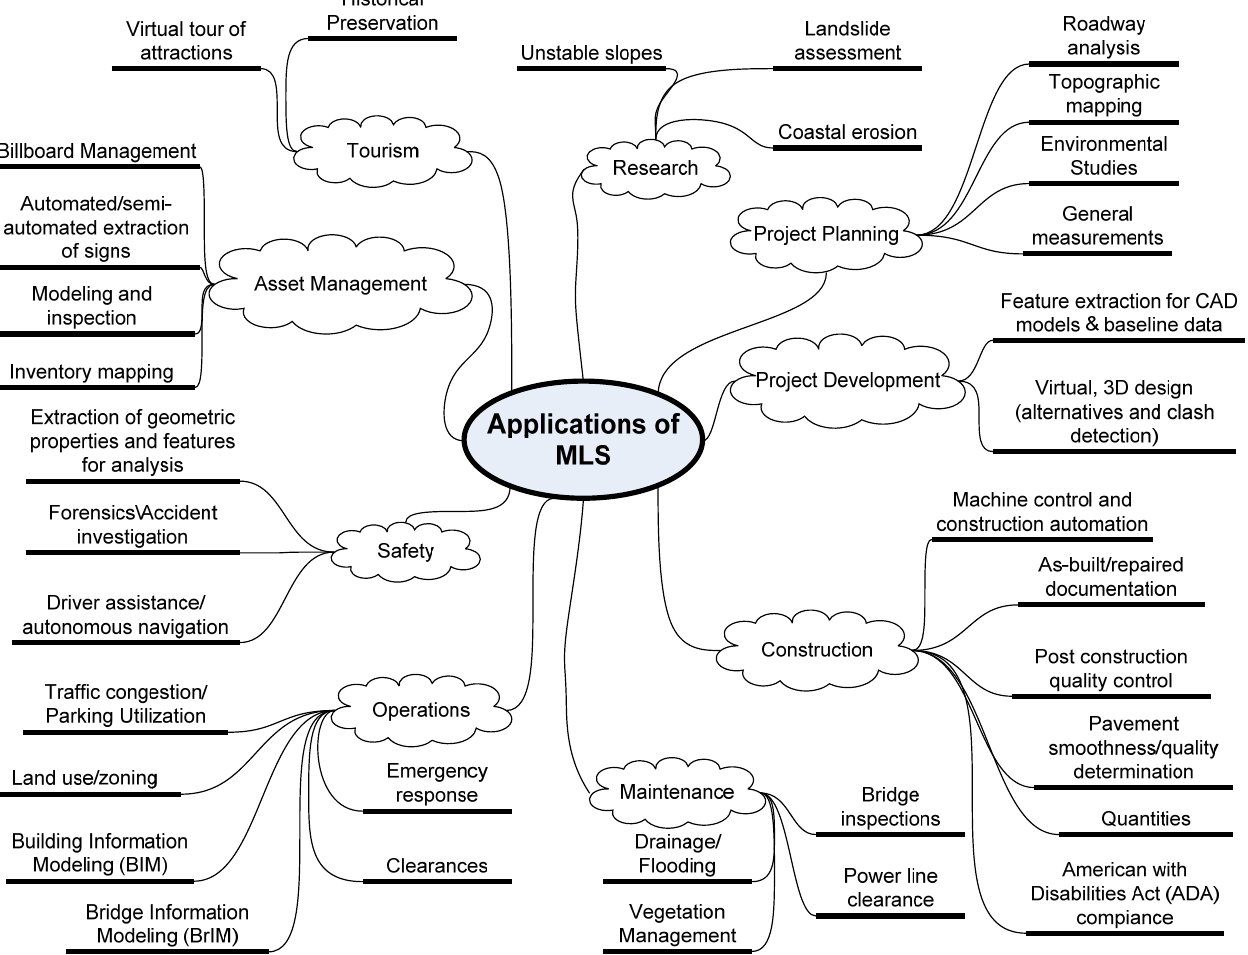
Figure 6. Graphical representation of common applications of